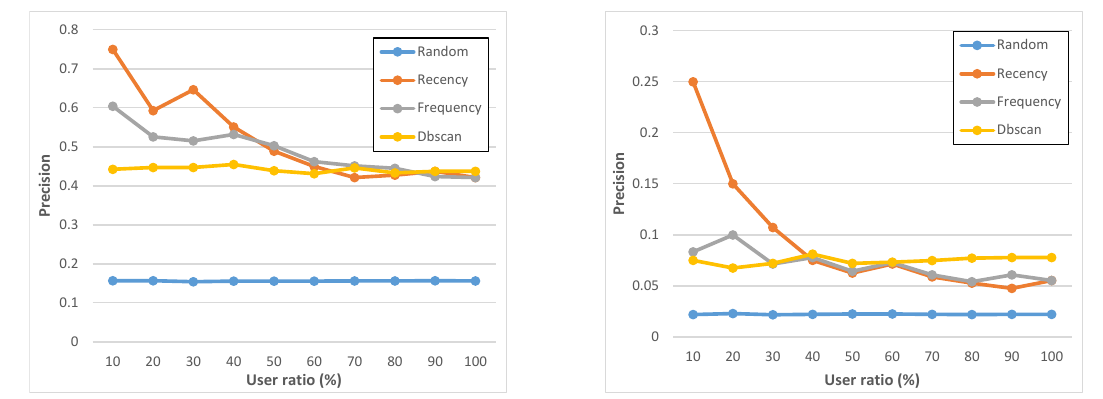
Figure 8. Precision of geo-notified ( left ) and non-geo-notified ( right )